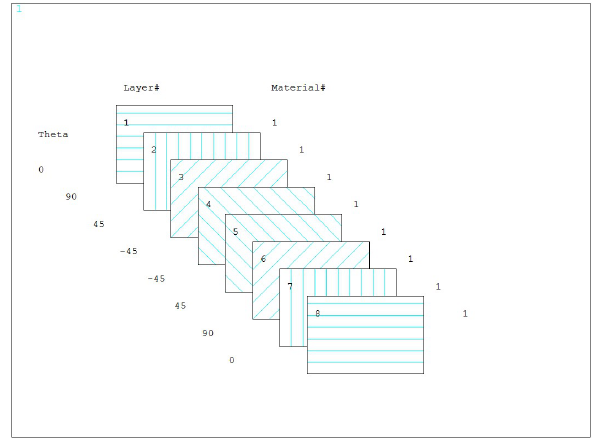
Figure 3: Initial displacements ( z